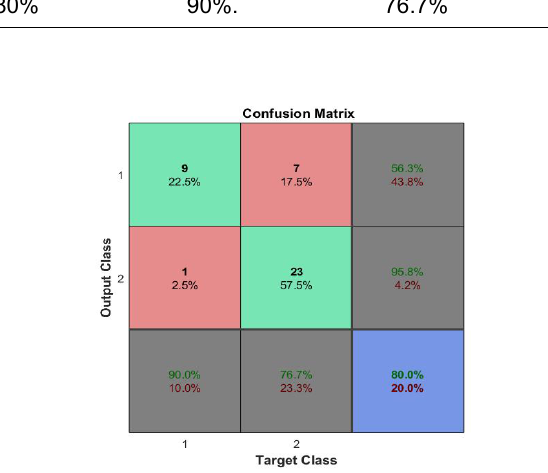
Fig 12. Confusion Matrix for classifying Normal and Abnormal Retinal